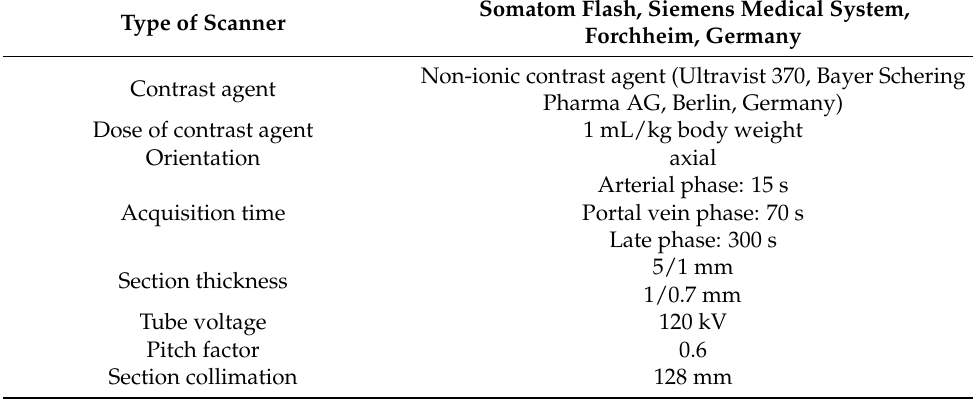
Table 2. Technical data CT